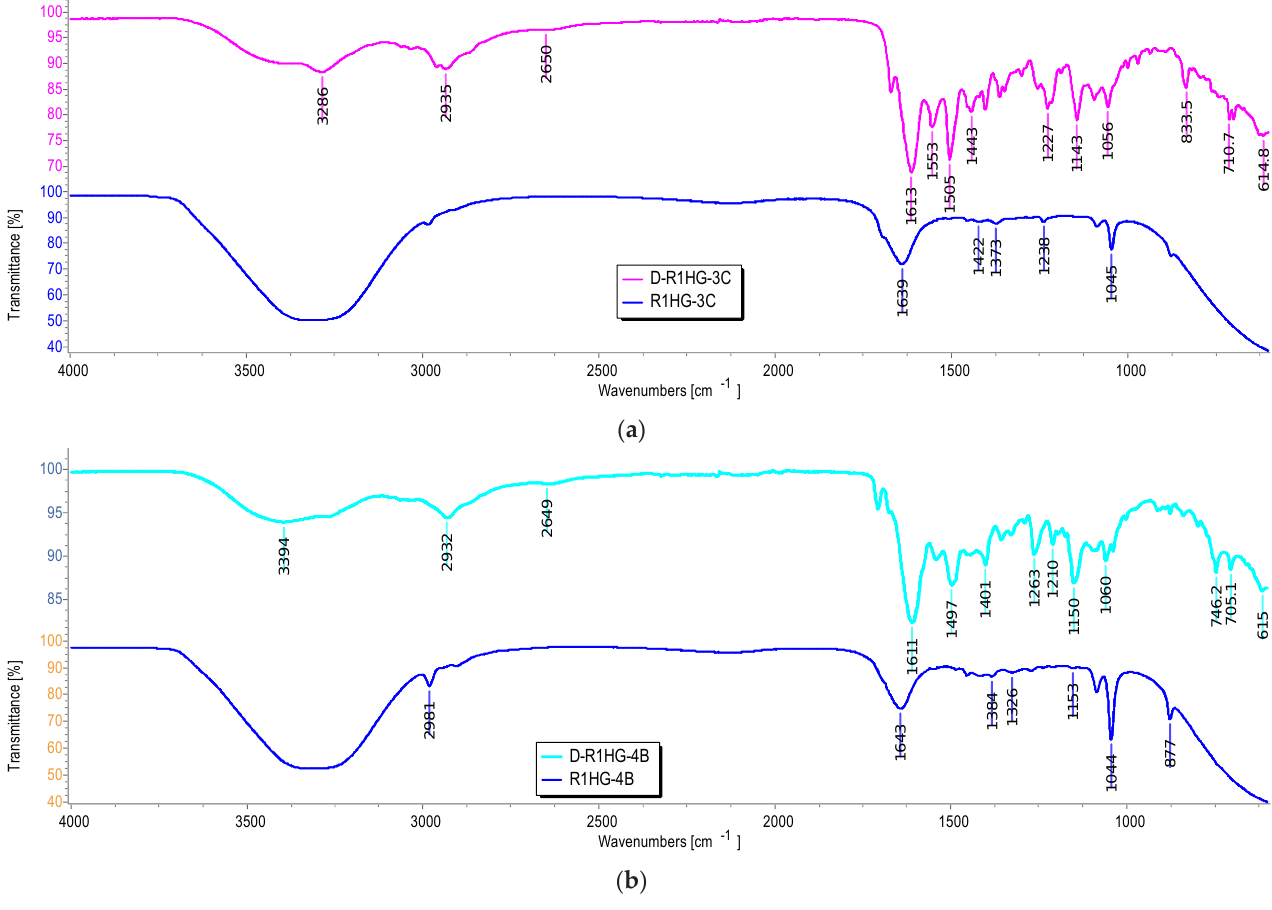
Figure 6. ATR-FTIR spectra of R1HG-3c and D-R1HG-3c ( a ) and of R1HG-4b and D-R1HG-4b ( b ). As expected, the ATR-FTIR spectra of the soaked R1HG-3c and R1HG-4b (blue lines in Figure 6a and 6b, respectively) were very simple, and showed only the typical bands of water (a large OH stretching band over 3000 cm − 1 and an OH scissoring band at 1639 and 1643 cm − 1 ), thus confirming the very high content of water in both hydrogels. Anyway, some weak bands indicating the presence of organic compounds were detectable, mainly in the spectrum of R1HG-4b at 2981, 1384, 1326, 1044, and 877 cm − 1 . In contrast, the ATR-FTIR of dried compounds D-R1HG-3c and D-R1HG-4b were very similar due to the presence of R1 as a major ingredient in both substances and the similar chemical structure of 3c and 4b , both containing the pyrazole nucleus. By comparing the spectrum of D-R1HG-3c with those of R1 and 3c , and that of D-R1HG-4b with those of R1 and 4b , bands deriving from R1 and typical of 3c or 4b were detectable (Figures 7a,b and 8). Particularly, in the spectrum of the dried D-R1HG-3c, bands deriving from R1 were observable at 2958, 2935 (CH stretching of methylene groups), 2650 cm − 1 , and at 1613 cm − 1 , (C=O stretching of the amide group of DMAA and AAEA) (Figure 7a). Additionally, bands of the main functional groups of 3c including a weak and large band at 3286 cm − 1 (OH and aromatic CH stretching), bands at 3061, 3030 cm − 1 , a weak band at 1671 cm − 1 (C=O stretching of ureic group), and several other bands typical of 3c at 1553, 1505, 1443, 1227, 1143, 1055, 834, and 711 cm − 1 (aromatic C=C and C-N stretching) characterized the spectrum of D-R1HG-3c. It was also evidenced that the interactions of 3c-R1-H 2 O that occurred during gel formation did not affect the main functional groups of 3c and R1.